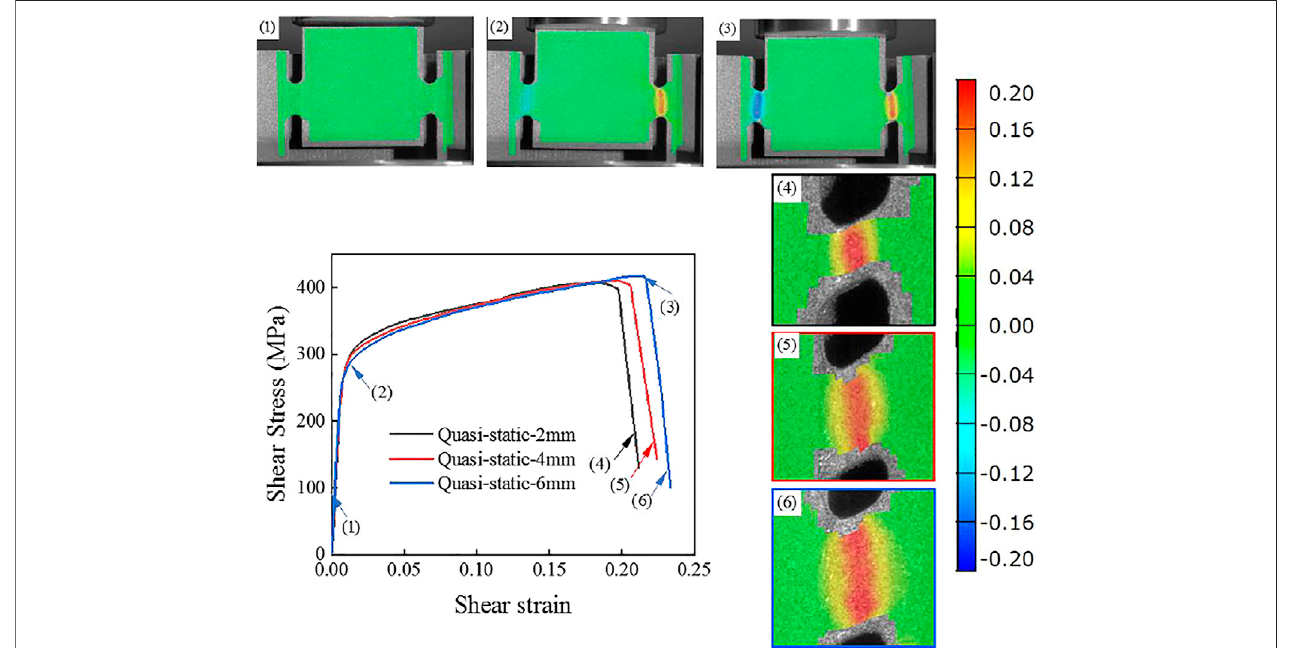
FIGURE 6 | Quasi-static shear stress – strain curves and the corresponding shear strain fi eld.